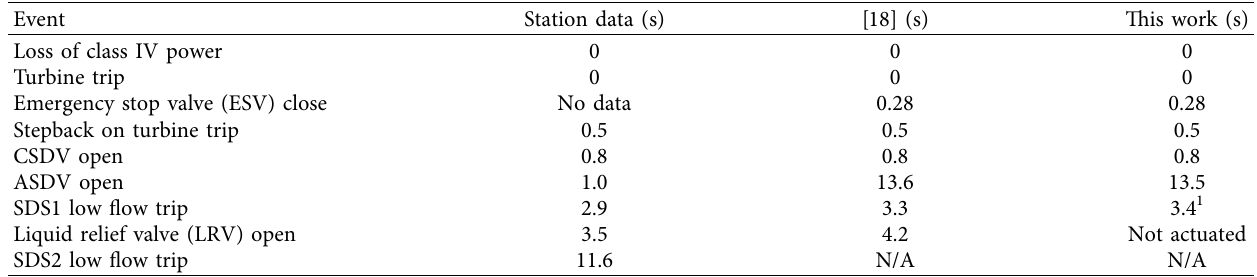
Figure 29: Flow oscillations at reduced pressure, with balance headers unblocked after 600 seconds. The even pair of pumps and headers oscillate out-of-phase with the odd pair. Table 3: Event timings compared to station data and previous